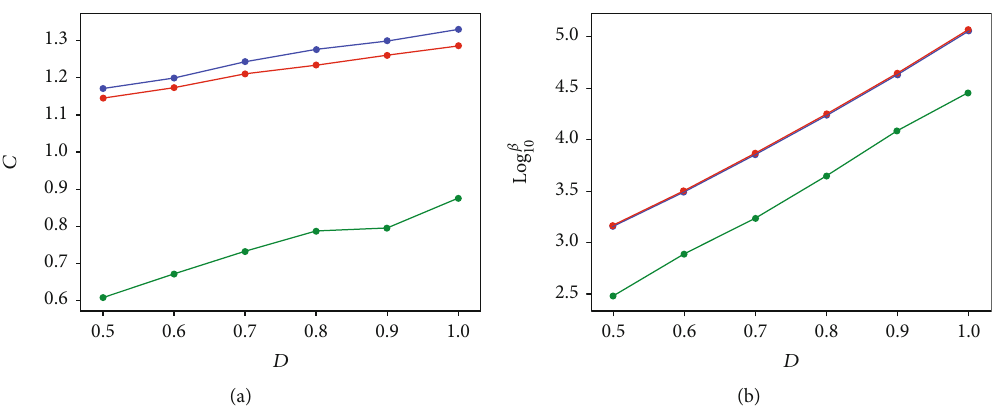
Figure 9: Variations of the dimensionless coe ffi cient (a) C and (b) β regarding the correlation exponent D . The blue color, red color, and green color denote k xx , k yy , and k xy , respectively.